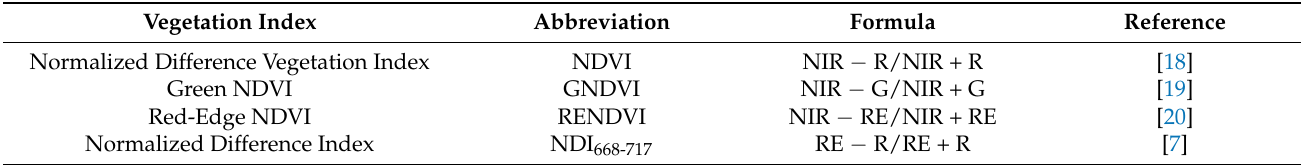
Table 3. Vegetation indices (VIs) computed using spectral data from the RedEdge-M TM